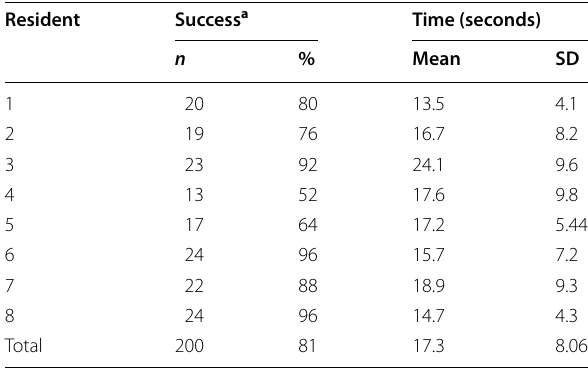
Table 2 Percentages and mean time for subxiphoid visu- alization of the IVC by novice EM Colombian